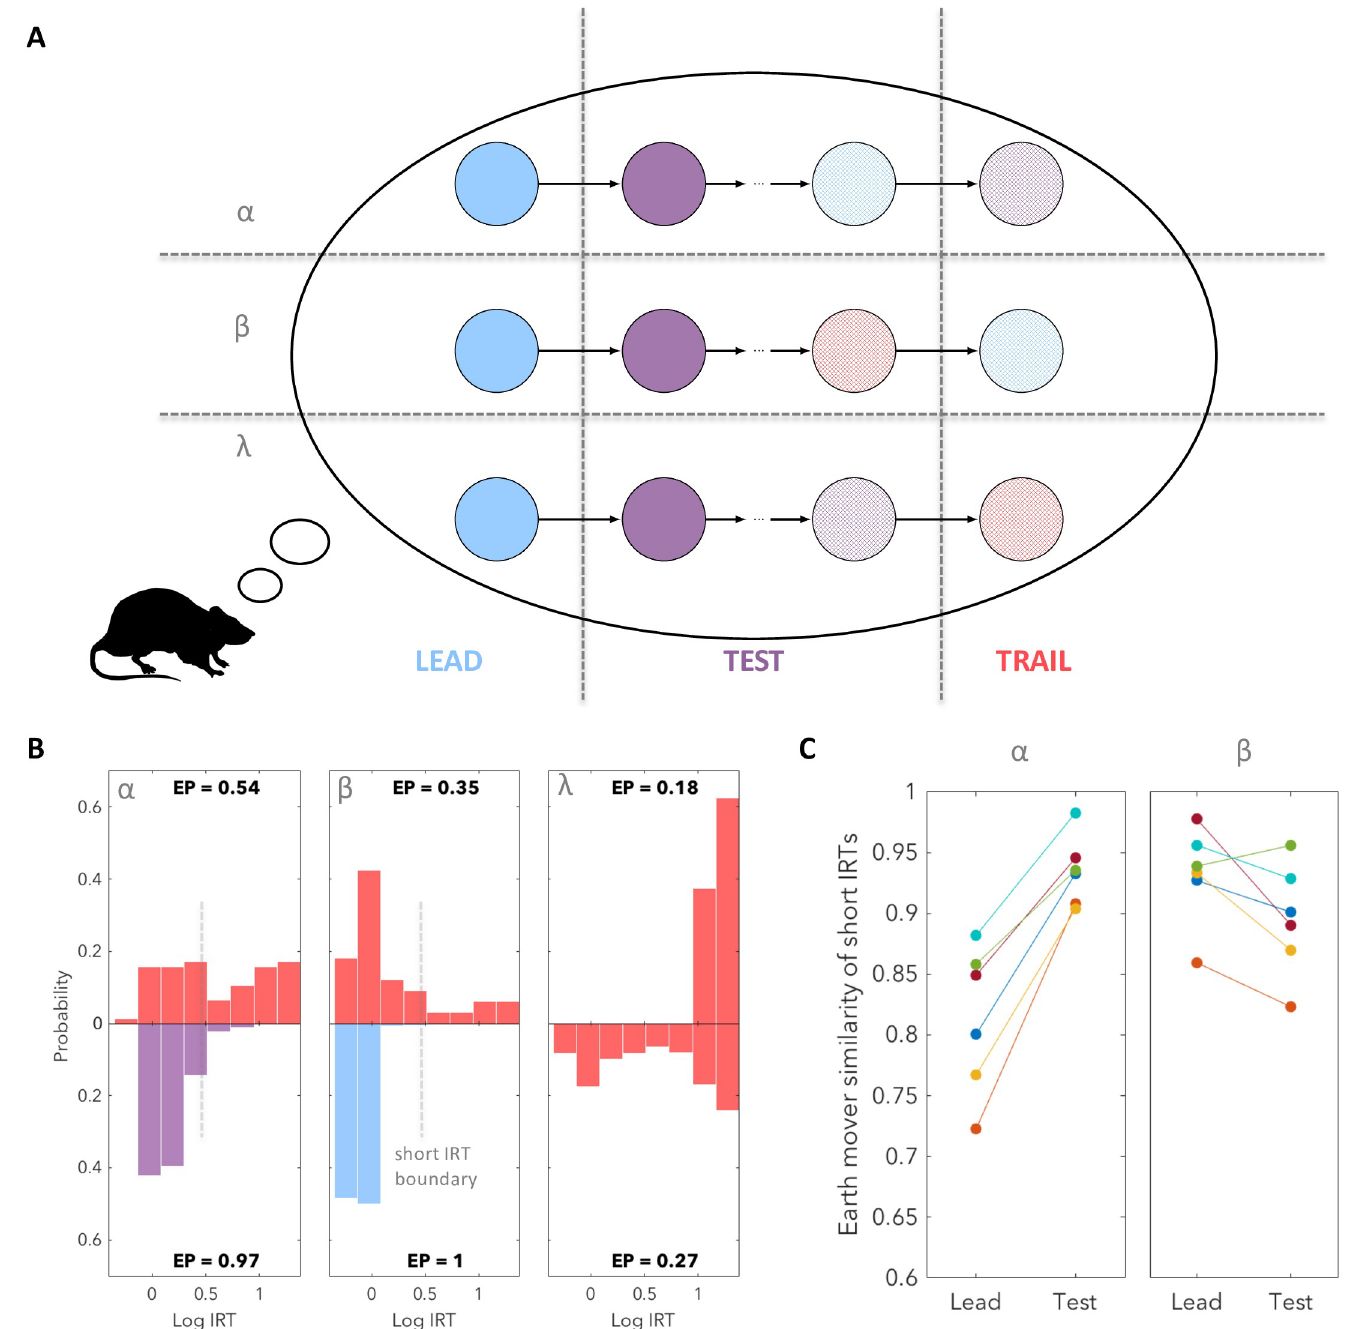
Fig 3. Short IRTs on comparatively worthless trail trials as mistaken inferences. ( A ) When a test trial had a frequency and price similar to that of either a lead trial or a trail trial (regions α and β respectively; Fig 1B), the subject’s belief about the trial type that they were experiencing may have been mistaken by the time the trial ended. If this incorrect belief was combined with a correct understanding of the transition structure of the task, then the subject would have expected the next trial to be a test or lead trial respectively, rather than a trail trial, and so would have chosen a short IRT rather than no response or a long IRT. By contrast, if the frequency and price were dissimilar to both lead and test trials (region λ ; Fig 1B), then the test trial would be unambiguous and the subject would either not respond at all, or would elect a long IRT on what it considered to be the subsequent trail trial. These effects are likely to be probabilistic, which we indicate by lighter shading. ( B ) We tested this hypothesis by examining trail trial responses given that the preceding test trial’s frequency and price were in regions α , β or λ . To aid visual comparison of histograms for subject 1 we use a mirror plot. Left: When test trials had similar frequency and price to lead trials (region α ), the resulting distribution of short trail trial IRTs (upper) was test-like (the lower left plot shows the actual distribution of IRTs on test trials). Middle: when test trials were similar to trail trials (region β ) the resulting distribution of short trail trial IRTs (upper) was lead-like (lower plot). Right: when test trials were dissimilar to both lead and test trials (region λ ), short IRTs